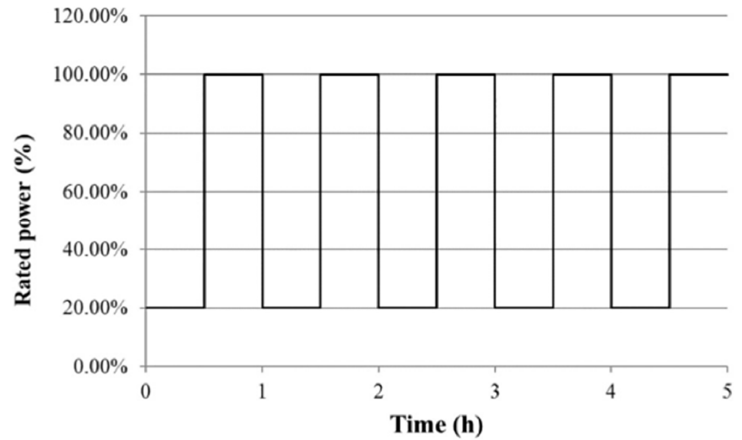
Figure 6. Duty cycle from International Electrotechnical Commission (IEC) and Fuel Cell Testing